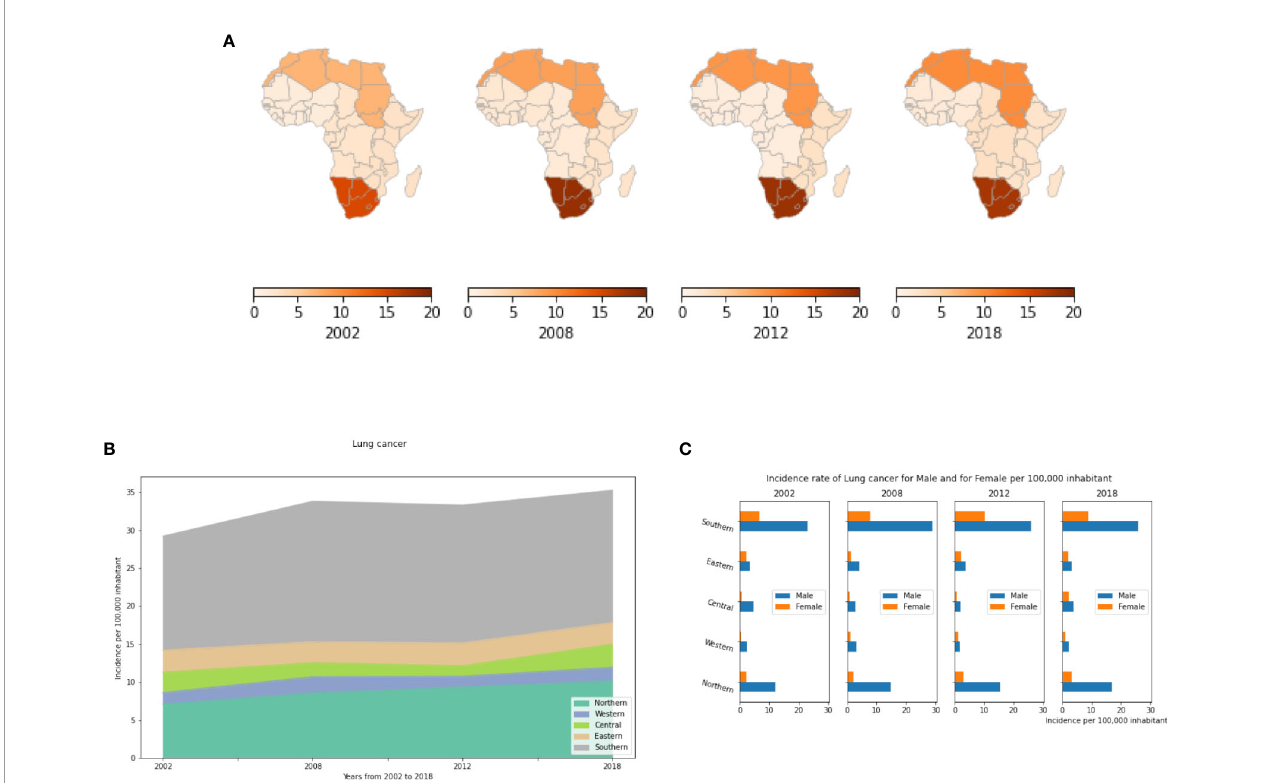
FIGURE 4 | Lung cancer incidence rates by African region, per year and by gender. (A) Incidence rate per 100,000 inhabitant by African regions. (B) Dynamics of Changes of incidence rates from 2002 to 2018. (C) Lung cancer Incidence rates by gender in different African regions. This represents the number of active cancer cases per year per 100,000 men and per 100,000 women in each African